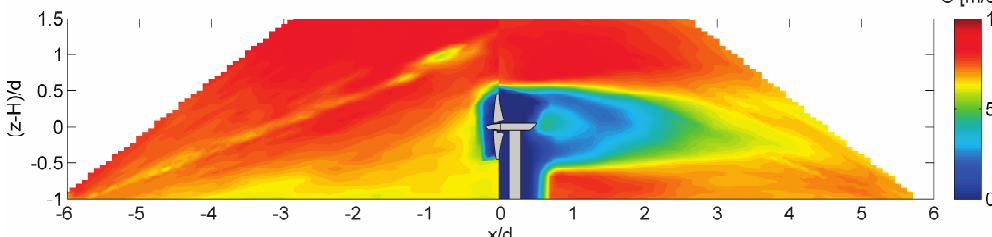
Figure 1. Velocity field measured over the wake vertical symmetry plane through simultaneous RHI scans with two LiDARs.